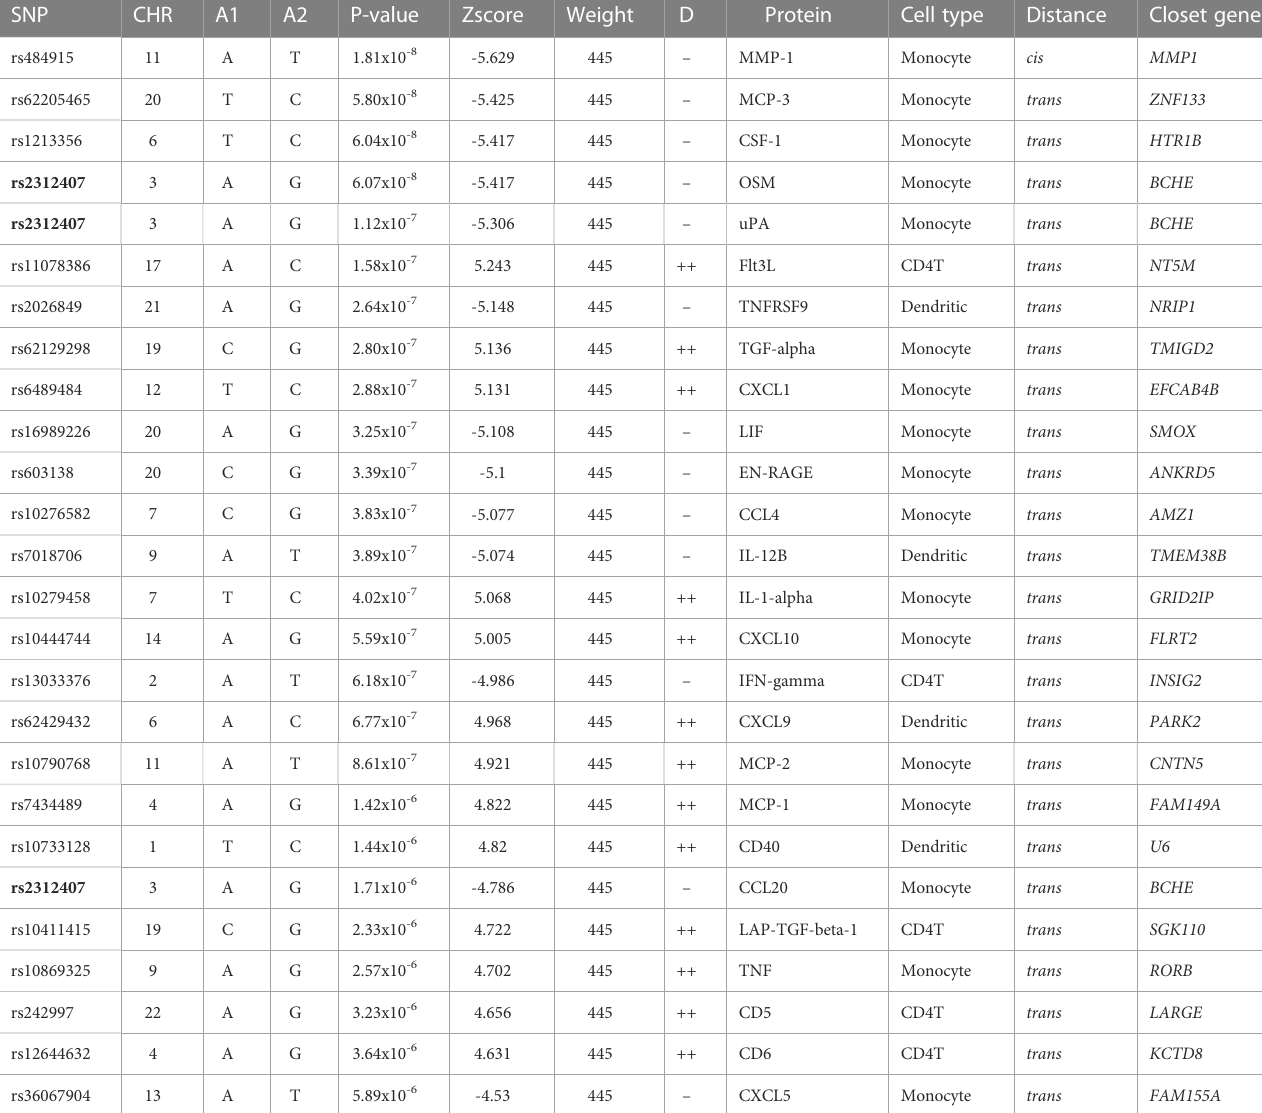
TABLE 1 Summary of the top pQTLs from meta-analysis of 26 proteins common in 500FG and